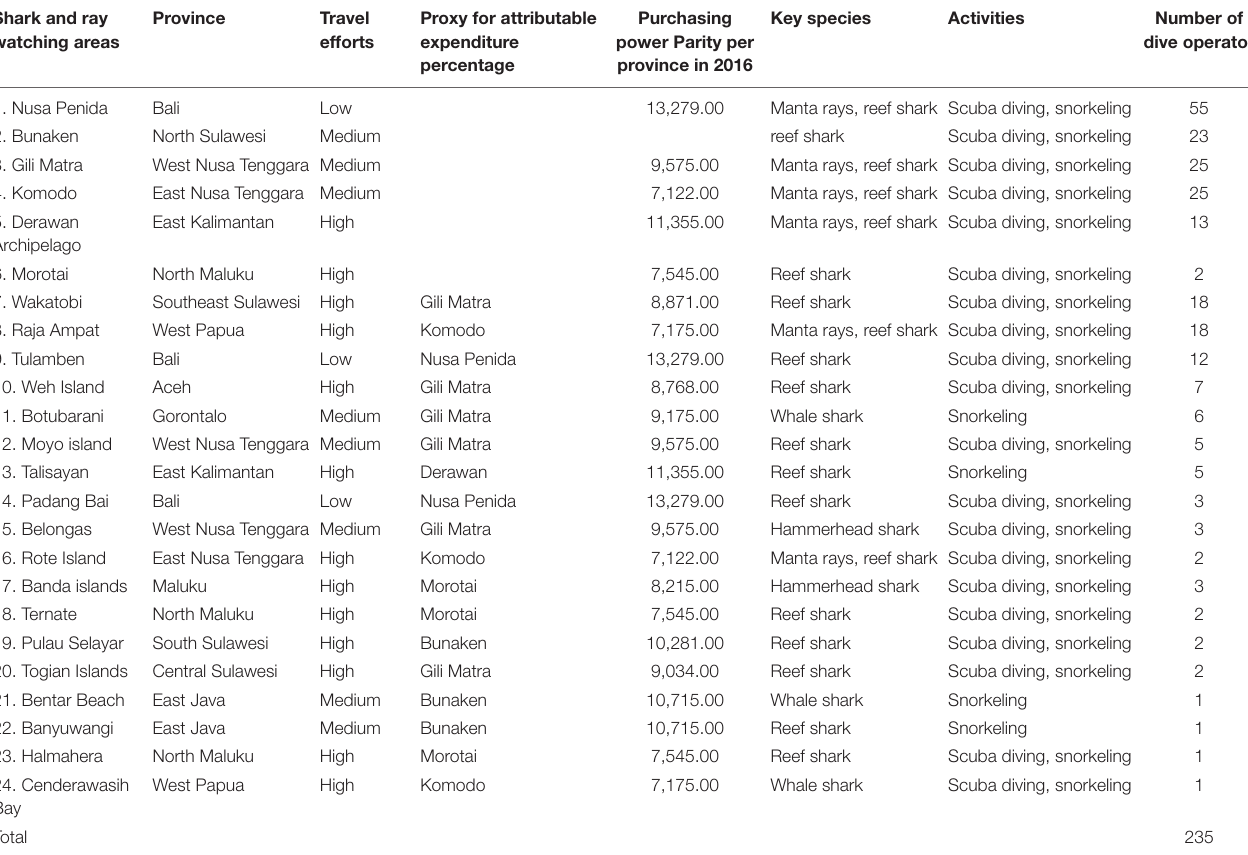
TABLE 4A | Estimated annual shark and ray expenditures (USD) for 235 dive operators in Indonesia. Shark and ray watching